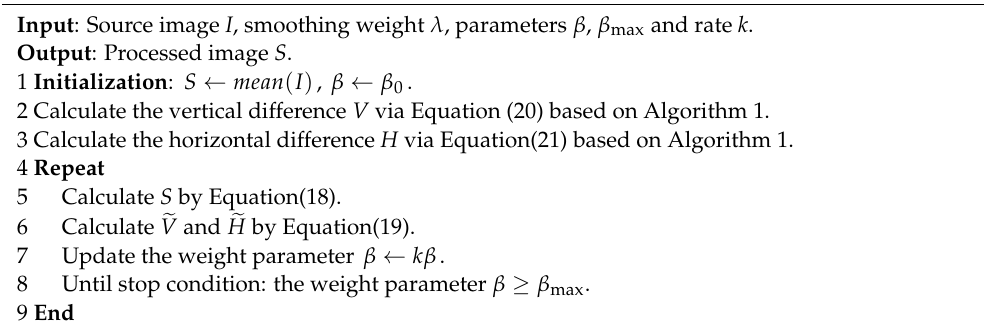
Algorithm 2. Image smoothing via counting zero crossings